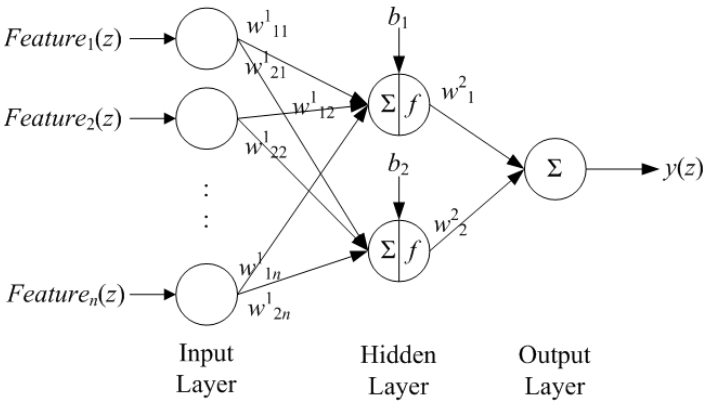
Figure 5. The structure of the proposed neural network.